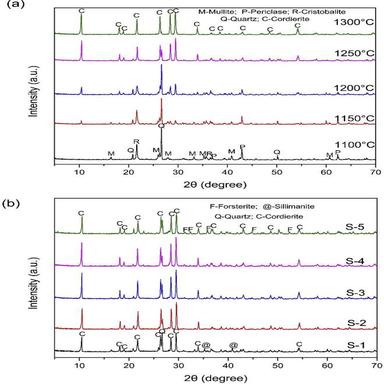
XRD patterns of different samples. (a) S-3 sintered at different temperatures for 2 h and (b) samples with different magnesite addition sintered at 1250 °C for 2 h.